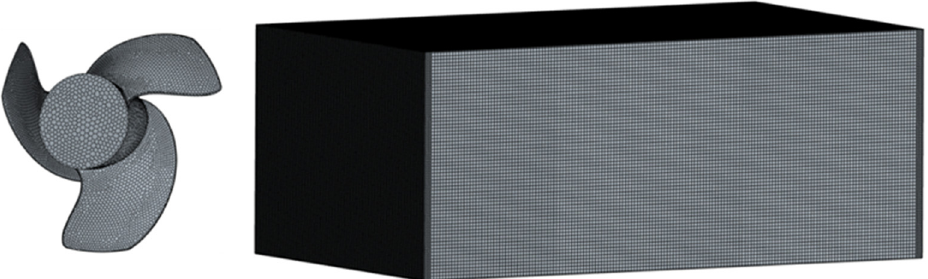
Figure 2. Meshing of impeller and pool.